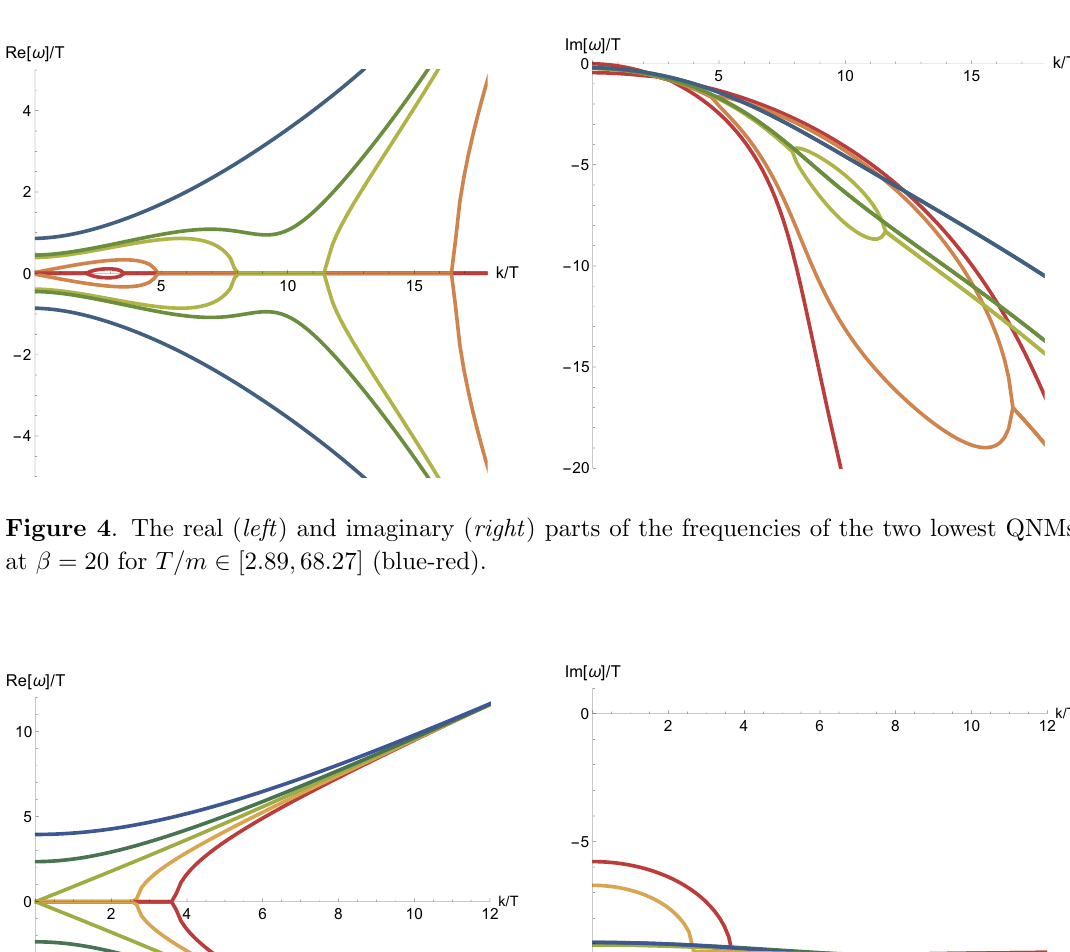
of rotons (green line). Eventually, for high enough temperatures the two modes recollapse and become purely imaginary again at (yellow, orange and red lines in (cid:12)gure 4). This phenomenon is absent for (cid:12) = 0 as shown in (cid:12)gure 5. The imaginary part of the frequency behaves \complementarily" to the real part in the following sense. When the modes are propagating, i.e. the real parts are non-zero, the imaginary parts are identical and both modes have the same decay rate. On the contrary, when the modes become purely imaginary, they decouple and show di(cid:11)erent decay rates. Similar behavior has been previously found in holography [74,